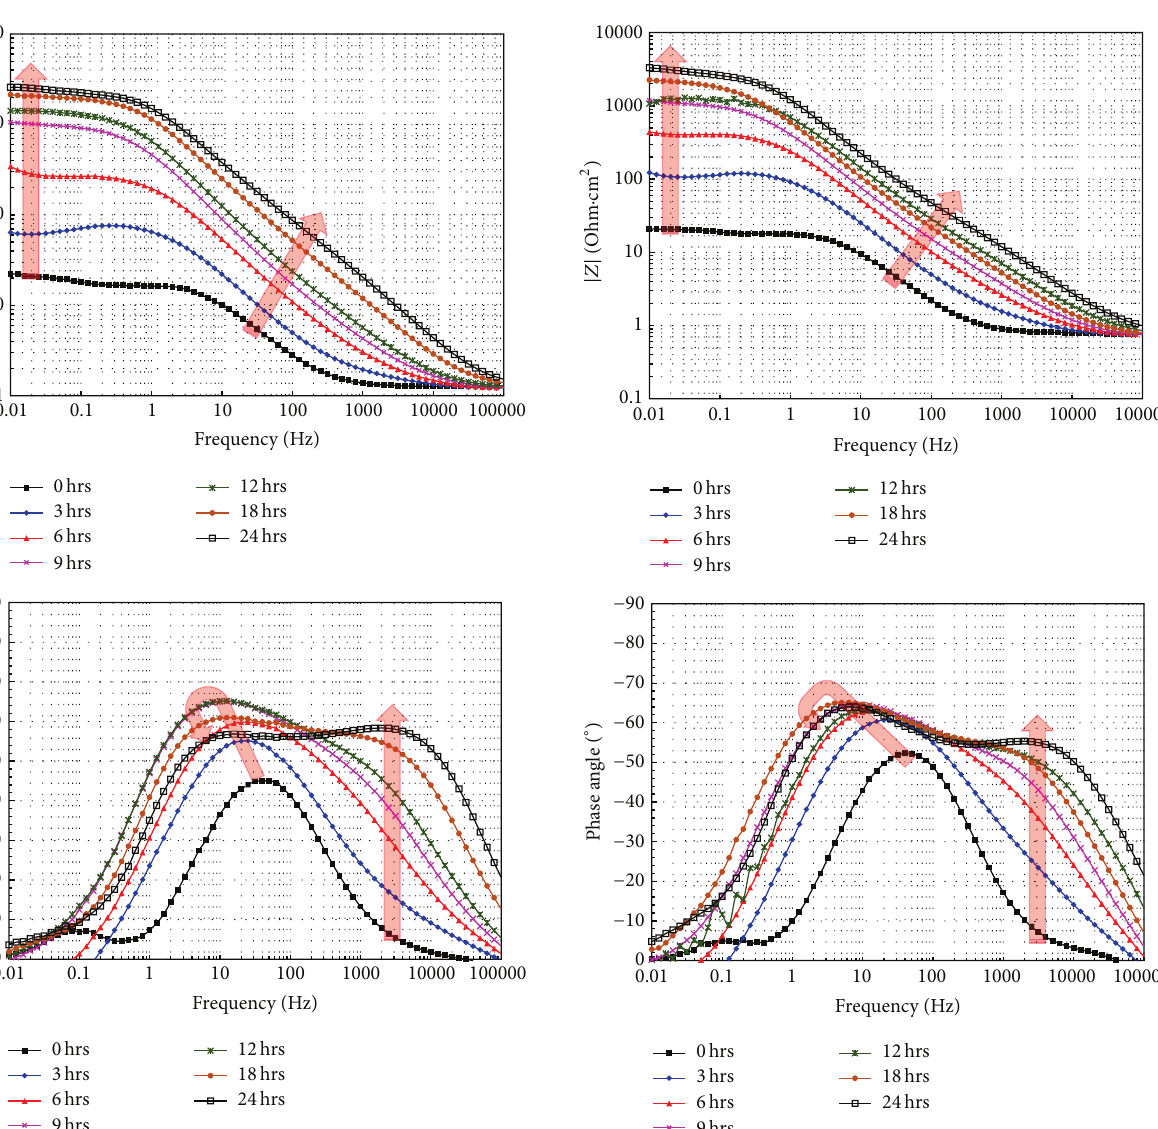
Figure 8: Nyquist and Bode plots for 1018 carbon steel in CO 2 - saturated (3% NaCl + 10% diesel) emulsion with 25 ppm of oleic amide at 50 ∘ C.